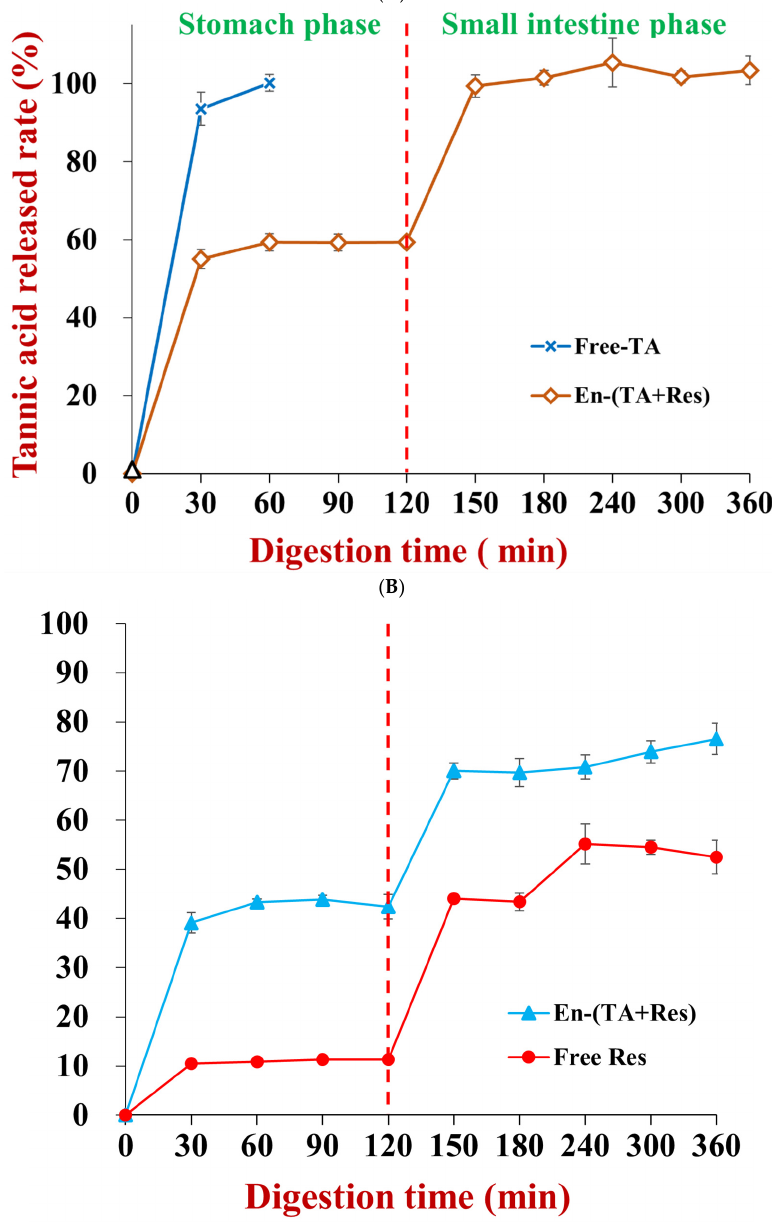
Figure 10. The releasing behavior of tannic acid ( A ) and resveratrol ( B ) from co-encapsulated nanoparticles during in vitro simulated gastric and small intestinal digestion.